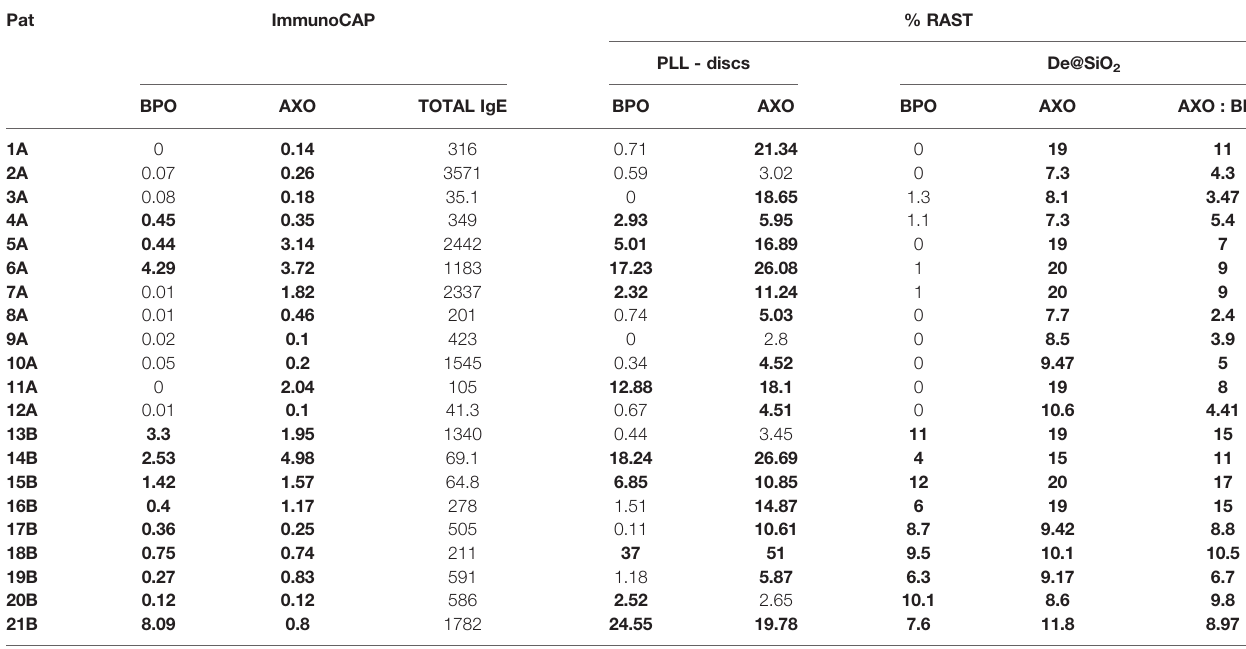
TABLE 3 | In vitro results of determination of drug-sIgE antibodies of the patients diagnosed with an immediate allergic reaction to AX, performing different immunoassays: standardized ImmunoCAP and customized RAST using cellulose discs or silica particles as solid